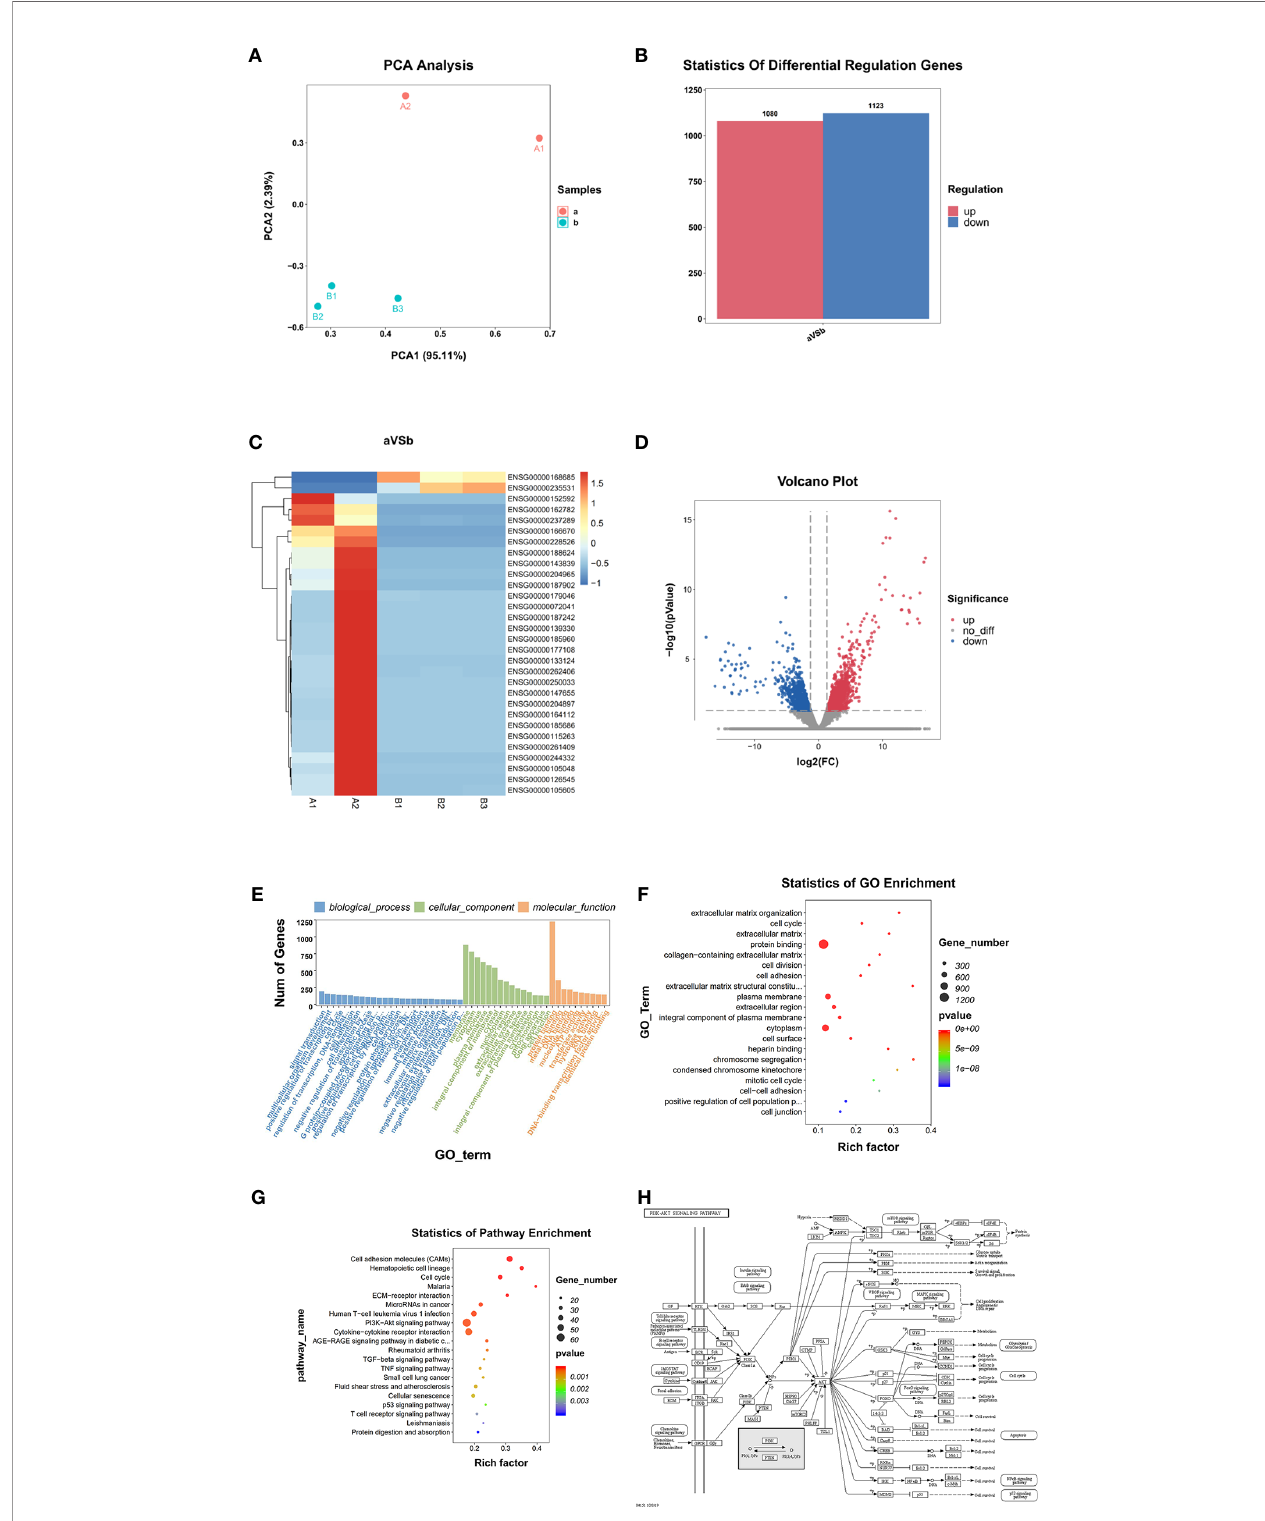
FIGURE 4 | Differential gene screening and analysis. (A) PCA Analysis; (B) Differential Regulation Genes. a: Tumor tissue, B: Normal tissues; (C) Heat map. A1, A2: Tumor tissue (Child 1 and Child 2), B1, B2, B3: Normal tissues; (D) Volcano Plot. Blur: Down regulation DEGs. Red: Up regulation DEGs; (E, F) GO Analysis, (G) Statistics of Pathway Enrichment; (H) PI3K-AKT signaling pathway (From: